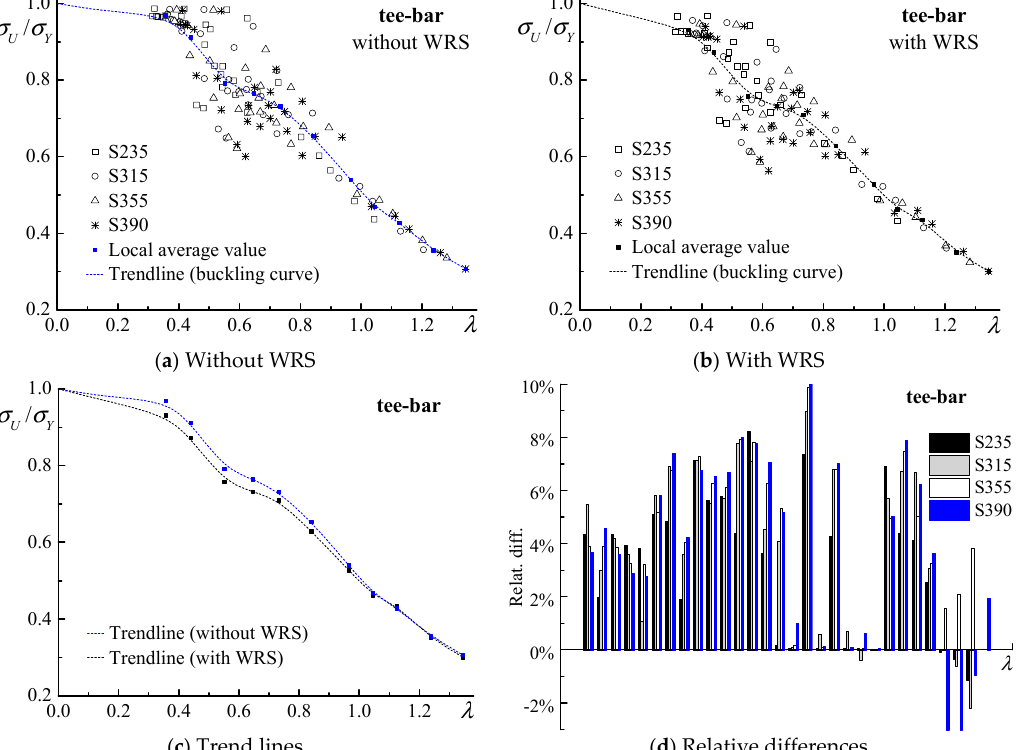
Figure 10. Ultimate strength of tee-bar stiffened plates versus column slenderness ratio.